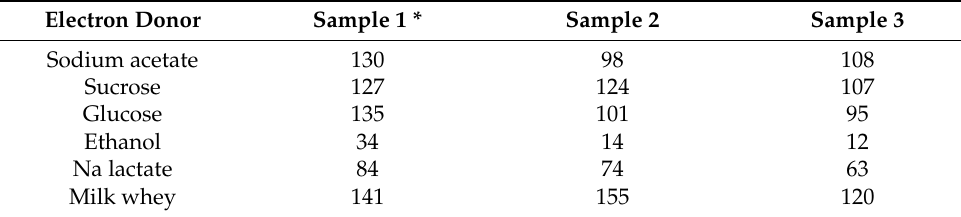
Table 4. Denitrification rate (mg NO 3 − /L/day) using various organic